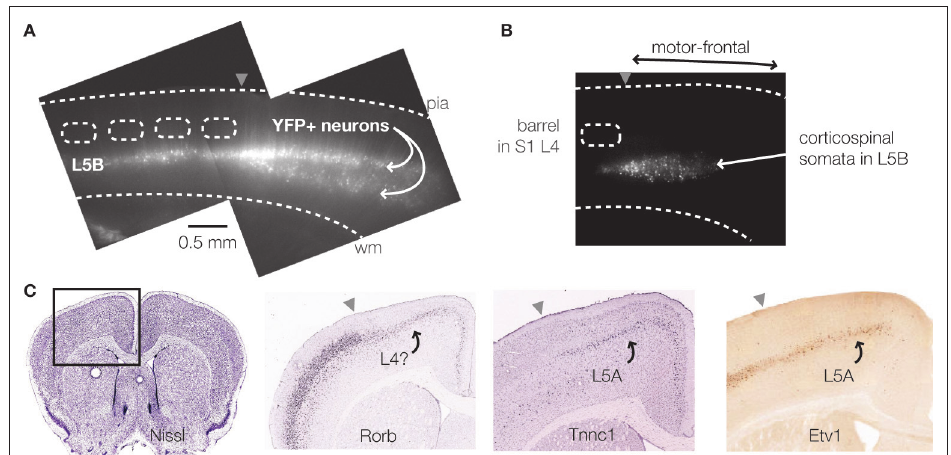
Figure 2 | Laminar stratification of cell classes. (A) Epifluorescence image of slice prepared from a YFP-H mouse. The single layer of YFP-positive neurons in L5B in somatosensory cortex expands to two bands in L5B of motor-frontal cortex. (B) Laminar epifluorescence image of slice showing location of corticospinal neurons in L5B. Neurons were retrogradely labeled by injecting fluorescent beads into the spinal cord. (C) Labeling patterns of molecular markers. Coronal section through the mouse’s motor-frontal cortex (far left). Gene expression pattern of Rorb, a layer 4 marker, shows strong expression in granular (somatosensory) cortex, and weak expression in agranular (motor-frontal) cortex. Expression pattern of Tnnc1 shows layer 5A-like pattern in motor-frontal cortex. That for Etv1 is similar in granular and agranular areas. Sources: GENSAT (www.gensat.org) (far right), and Allen Brain Atlas’ reference atlas (mouse.brain-map.org) (all